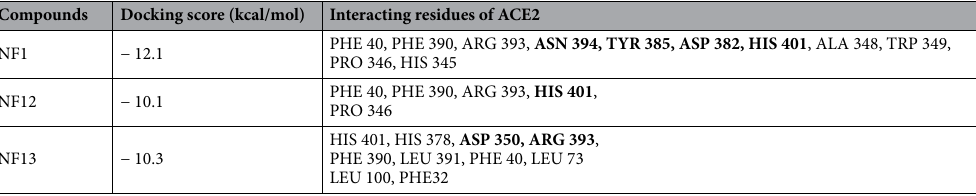
Table 1. The Bold highlighted residues (ASN 394, TYR 385, ASP 382, HIS 401, ASP 350, ARG 393) show hydrophilic interaction while other residues are showing hydrophobic interaction.